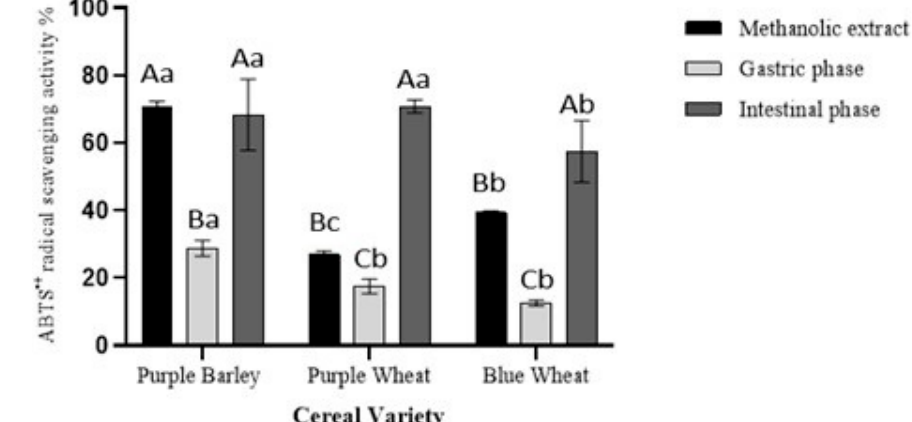
Figure 4. Total antioxidant activity extracts from digestion of pigmented cereal flour compared with a methanol extract measured using the ABTS •+ radical scavenging assay. Data shown is blank corrected, expressed as percentages and represents mean ± SD; n = 3. Different capitalized alphabets represent significant differences within a cereal variety. Different lowercase alphabets represent significant differences between cereal varieties.